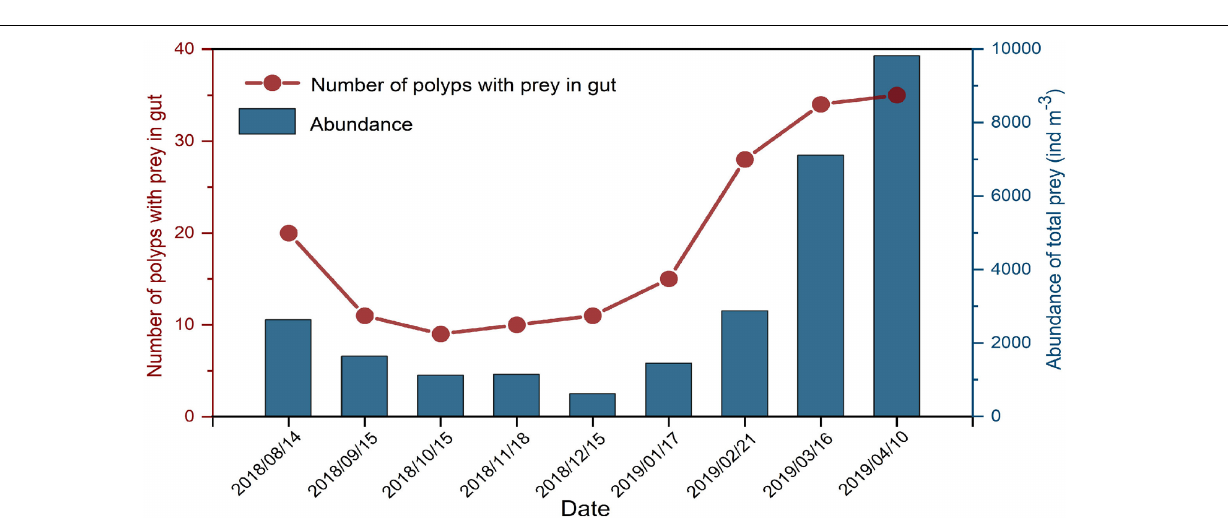
FIGURE 4 | Boxplot of the size diversities of A. coerulea polyps used for gut content analysis for each sampling date. One-way ANOVA analysis indicated that there were no significant differences in polyp sizes between different months ( F = 0.264, P = 0.976). The lower whisker, lower hinge, horizontal line, upper hinge, and upper whisker show minimum, lower quartile, median, upper quartile, and maximum size diversity, respectively. The squares in the boxplot indicated the mean values of polyp size.